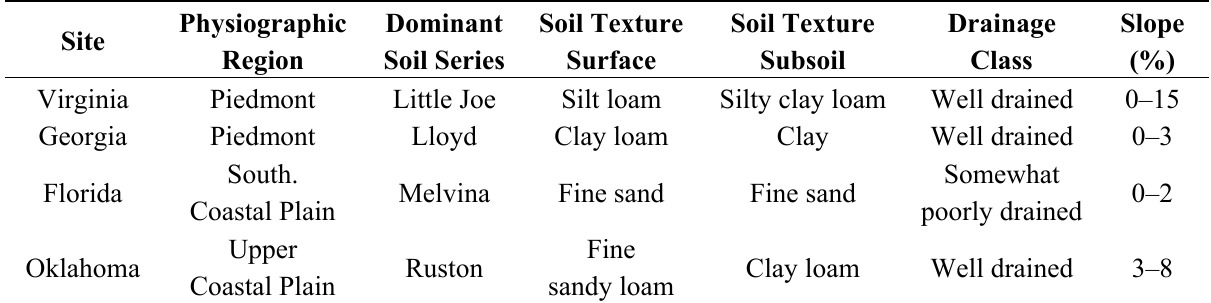
Table 2. Soil description for the four throughfall reduction x fertilization study sites established in non-thinned, mid rotation loblolly pine